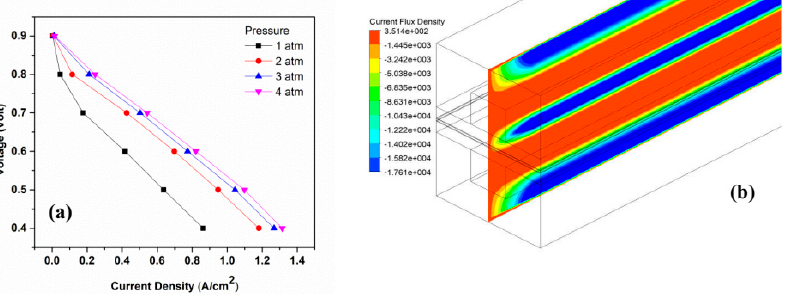
Figure 4. Effects of pressure on performance of PEMFC: ( a ) Polarization curves for pressure; and ( b ) Bontours of the current flux density at 0.6 V.